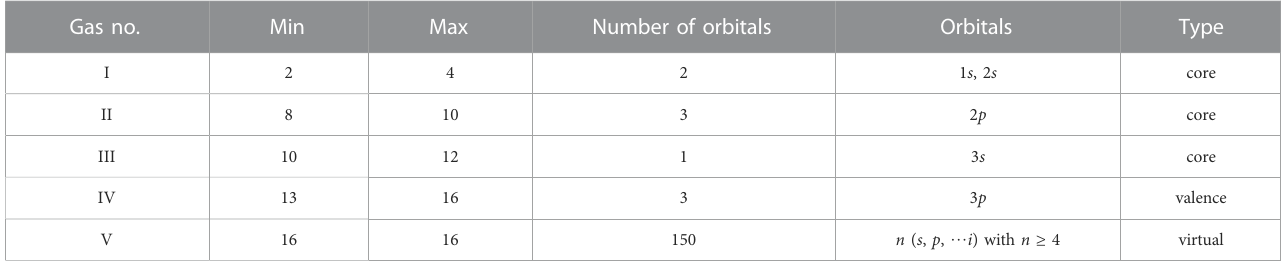
TABLE 11 Demonstration of GASCI scheme for Ni 12+ , where ‘ min ’ and ‘ max ’ denote the minimal and maximal number of accumulated electrons occupied in the respective core, valence, and virtual orbitals. Gas